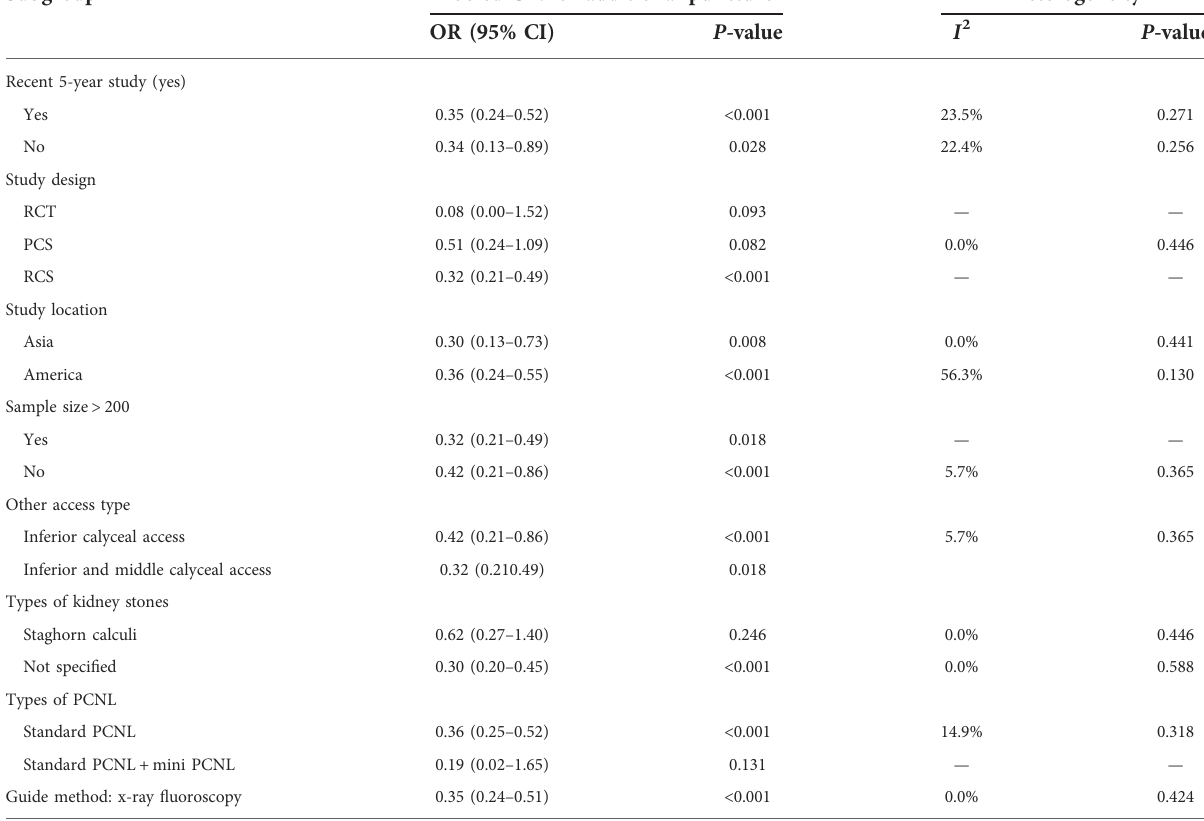
TABLE 2 Subgroup analyses of additional puncture comparison.